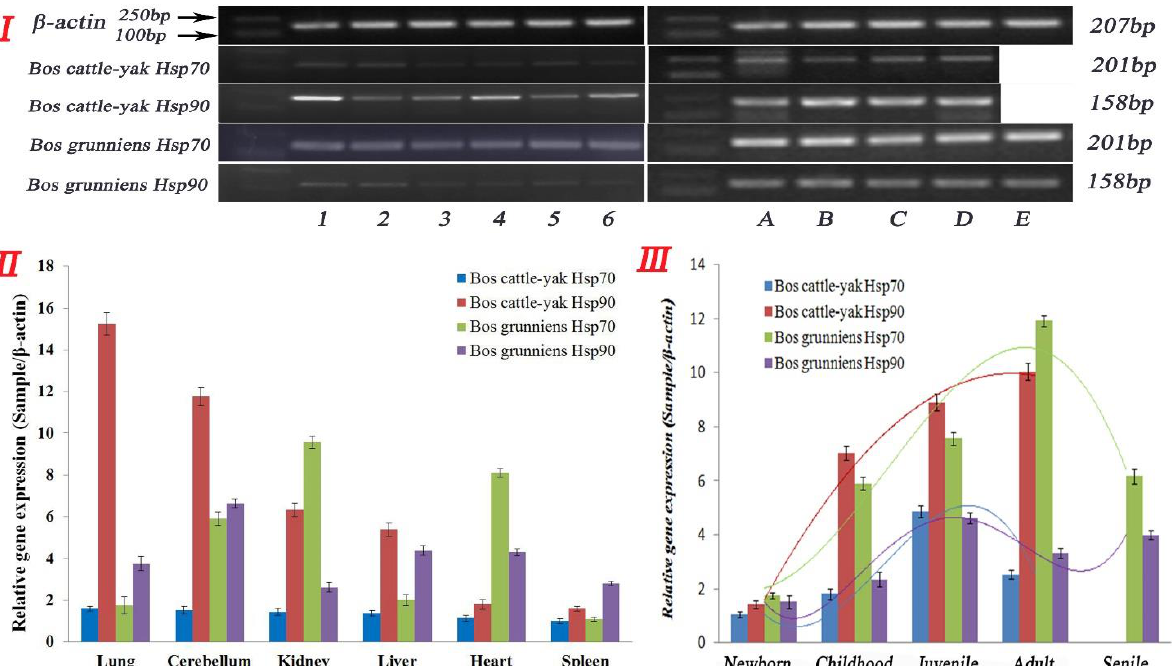
Figure 4. Gene expression in different tissues of cattle – yak and yak. ( I ) The results of RT-PCR. Lanes: (1) lung; (2) cerebellum; (3) kidney; (4) liver; (5) heart; and (6) spleen. Lanes: (A) newborn; (B) childhood; (C) juvenile; (D) adult; and (E) senile. ( II ) The gene expression levels of Hsp70 and Hsp90 in non-reproductive tissues from cattle – yak and yak. ( III ) Gene expression levels of Hsp70 and Hsp90 in testicular tissues from male cattle (cattle – yak and yak). Note: The curved lines represent expression trends of Hsp70 and Hsp90 proteins in different organs and different developmental stages in testis. Different colors represent different expressions of Hsp70 and Hsp90 in the organs and testicular tissue from cattle – yak and yak.